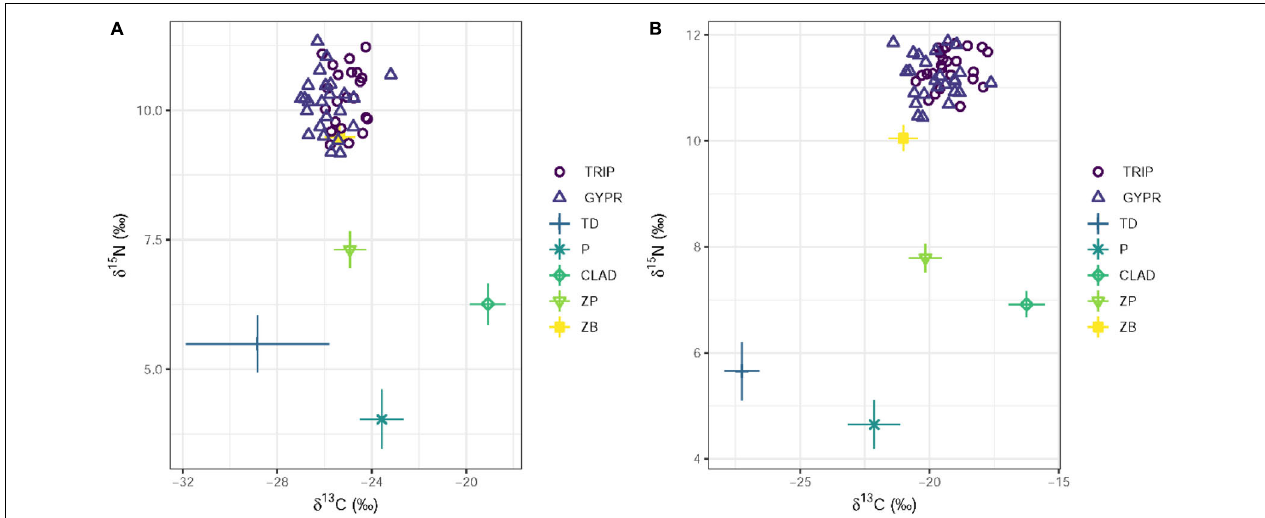
FIGURE 2 | Raw (not including trophic discrimination factors) stable carbon and nitrogen isotope values (mean ± SD) of basal food sources and consumers in original (A) and new (B) habitats. TRIP, Triplophysa ; GYPR, Gymnocypris przewalskii ; ZP, zooplankton; ZB, zoobenthos; P, phytoplankton; CLAD, Cladophora ; TD, terrestrial